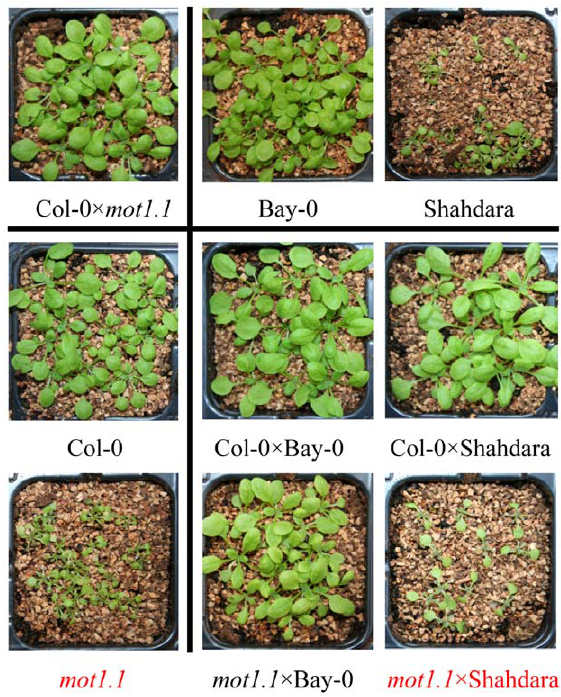
Figure 2. Mutant analysis and allelic complementation con- firms MOT1 as the likely causative gene. Peatmoss phenotype of diverse genotypes is shown, including Bay-0 and Shahdara parental lines, mot1.1 mutant and its wild-type genetic background (Col-0), and F1 plants from complementation crosses between these genotypes. Unlike other alleles, the Shahdara allele at MOT1 is not able to rescue the mutant phenotype.